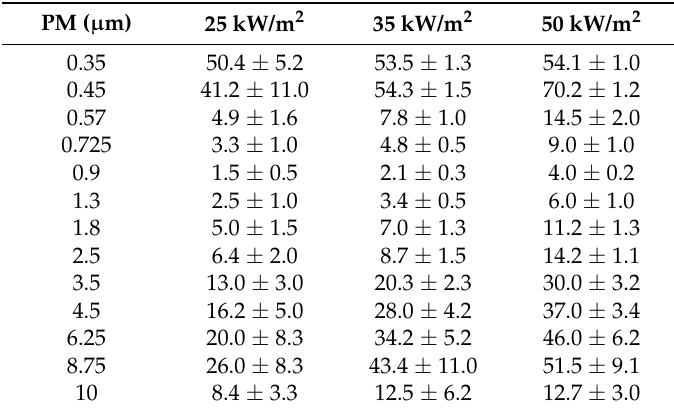
Figure 2. Particulate matter (PM) size distribution from vinyl combustion. Table 2. The concentration of particulate matter released in the combustion of vinyl.